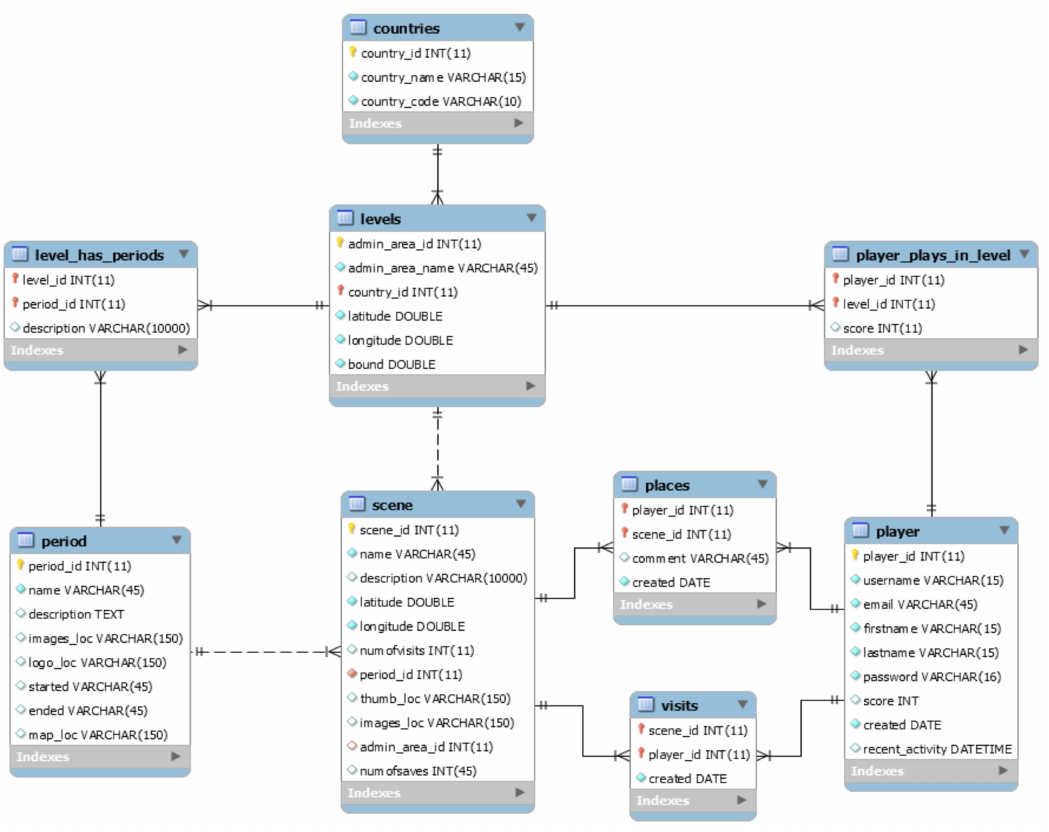
Figure 11. Database